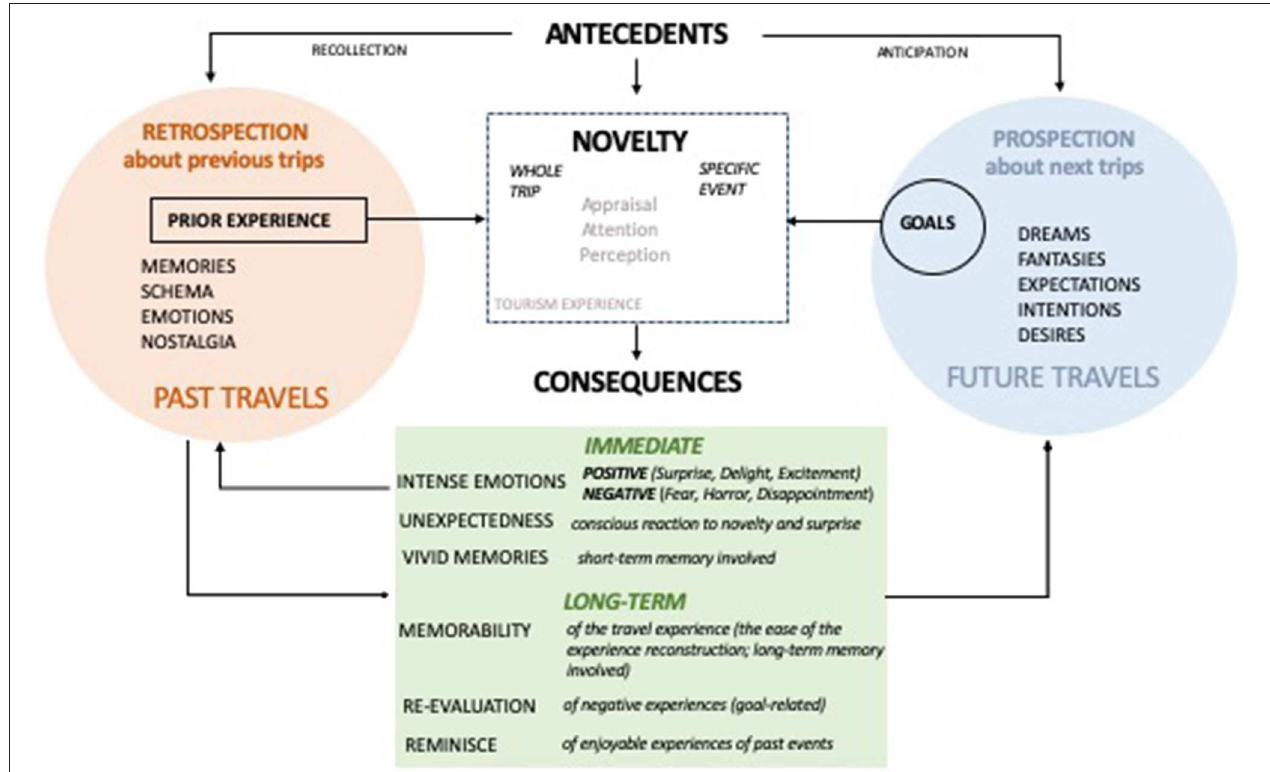
FIGURE 1 | Cognitive appraisal of novelty in